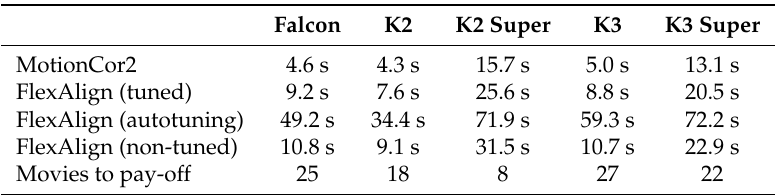
Table 4. Execution time on Testbed 1.